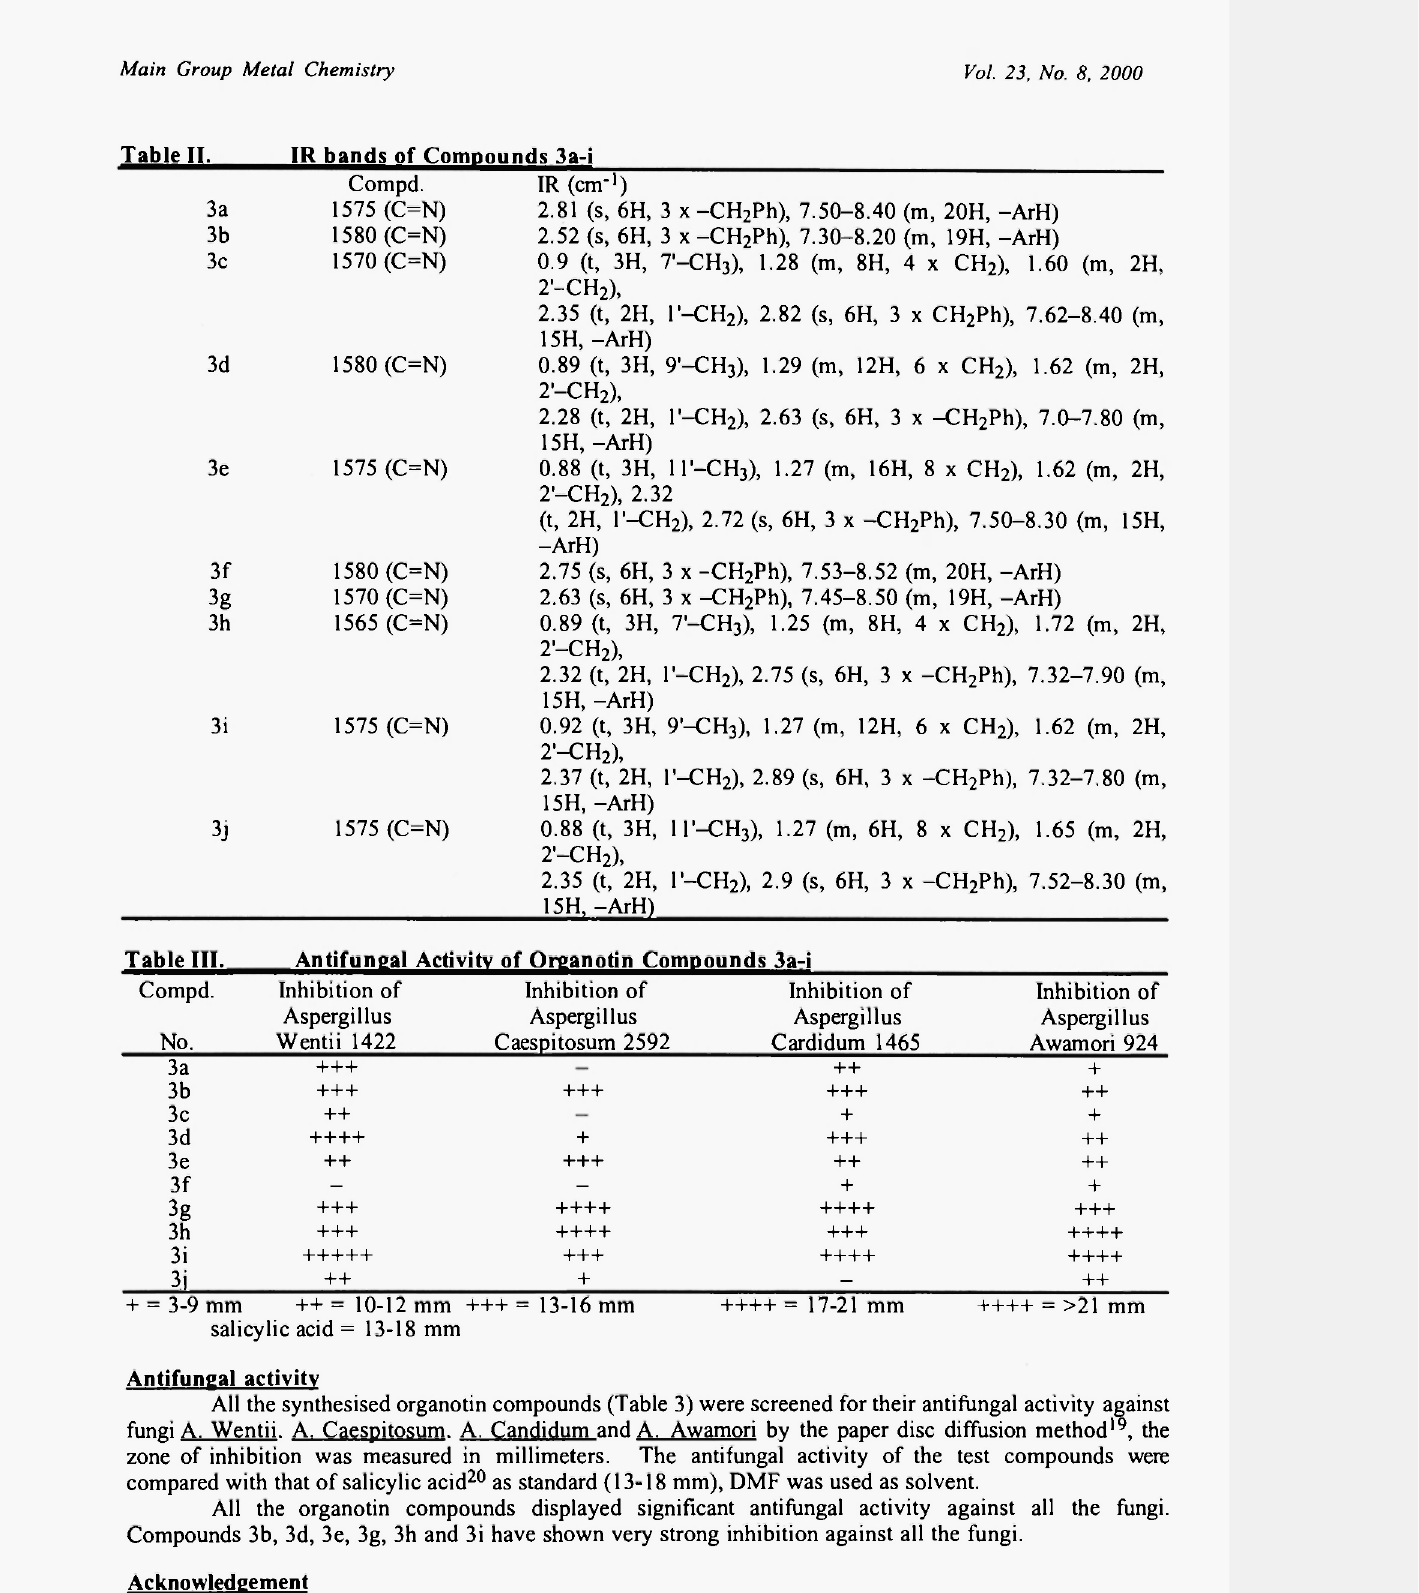
IR bands of Compounds 3a-i Compd.